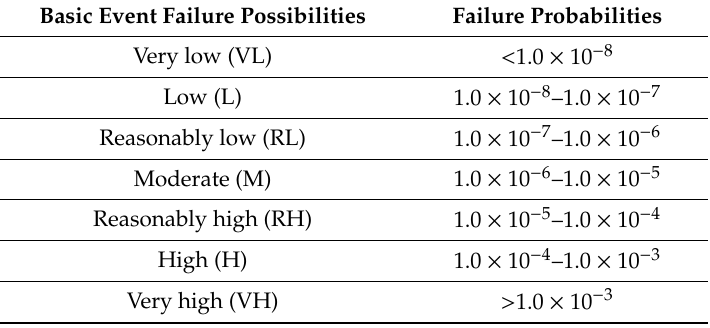
Table 2. Basic event likelihood values